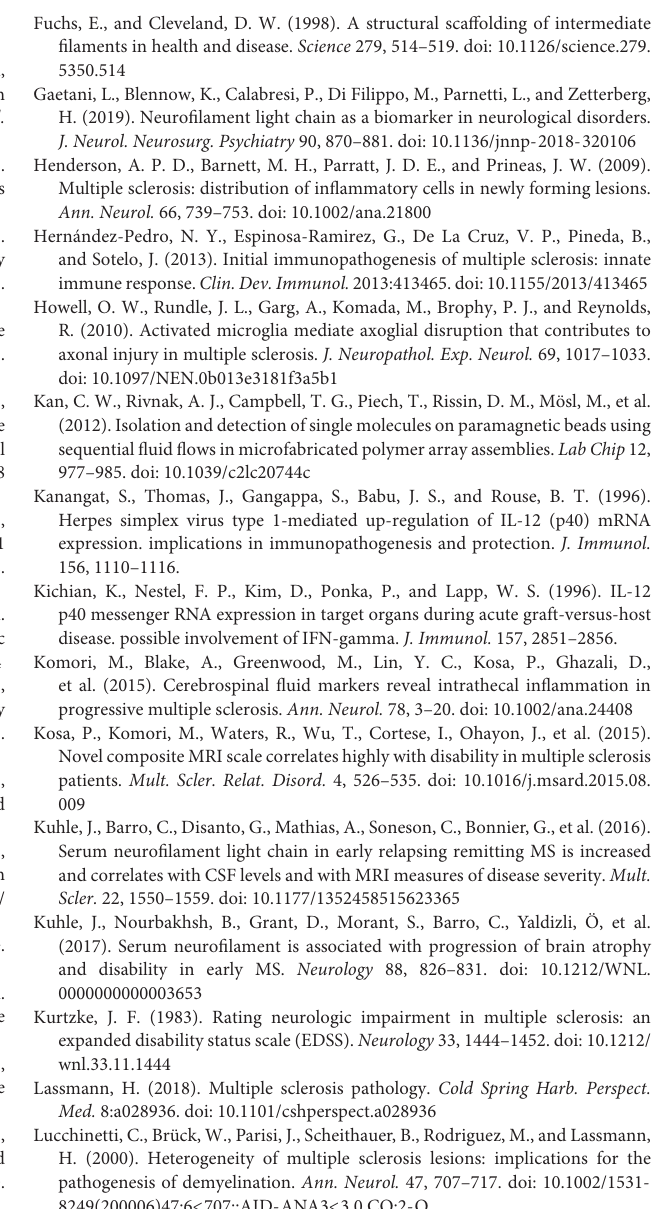
Supplementary Figure 1 | In the training cohort biomarker concentrations were compared across MS disease type (RR-MS vs P-MS) within respective lesional activity subgroups (inactive and active) using unpaired t -test (Inactive: RR-MS and P-MS, n = 7 and 28, respectively; Active: RR-MS and P-MS, n = 28 and 7, respectively). “+” sign represents mean of respective group. Supplementary Table 1 | In the training cohort, within MS patients ( n = 70) correlations between cNfL and other biomarkers were analyzed using Spearman